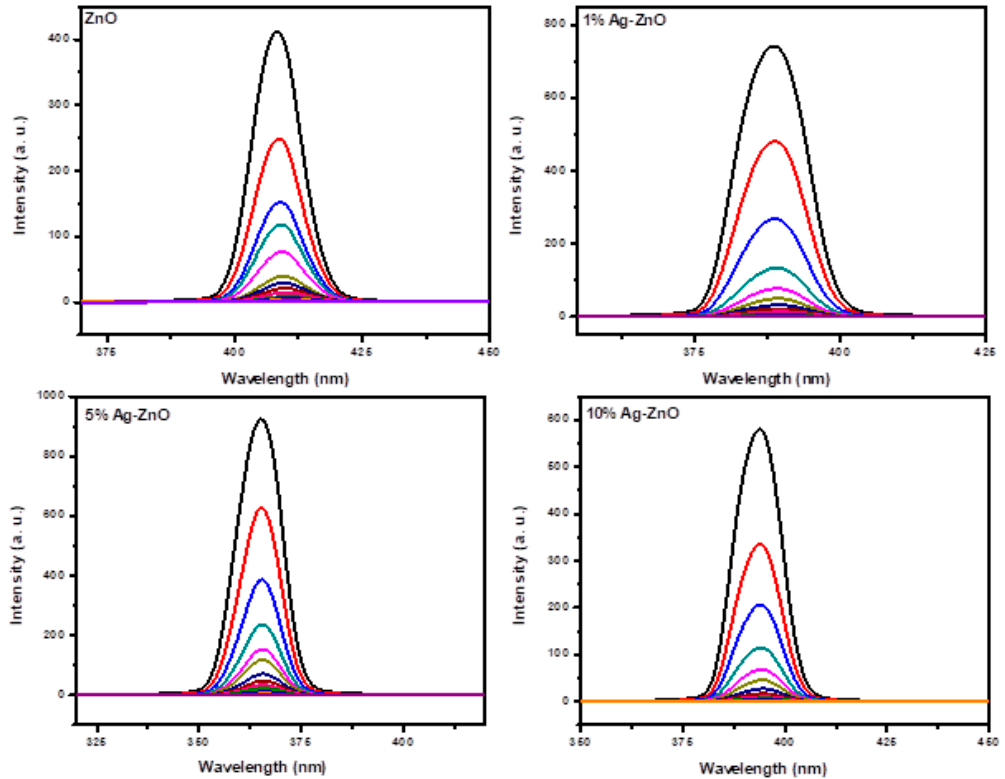
Figure 8. It was observed that the photoluminescence (PL) intensity of the pure ZnO and Ag-doped ZnO nanostructures decreases with an increase in the concentration of p-nitrophenol (PNP), which clearly indicates the binding of PNP to the surface of nanostructures.